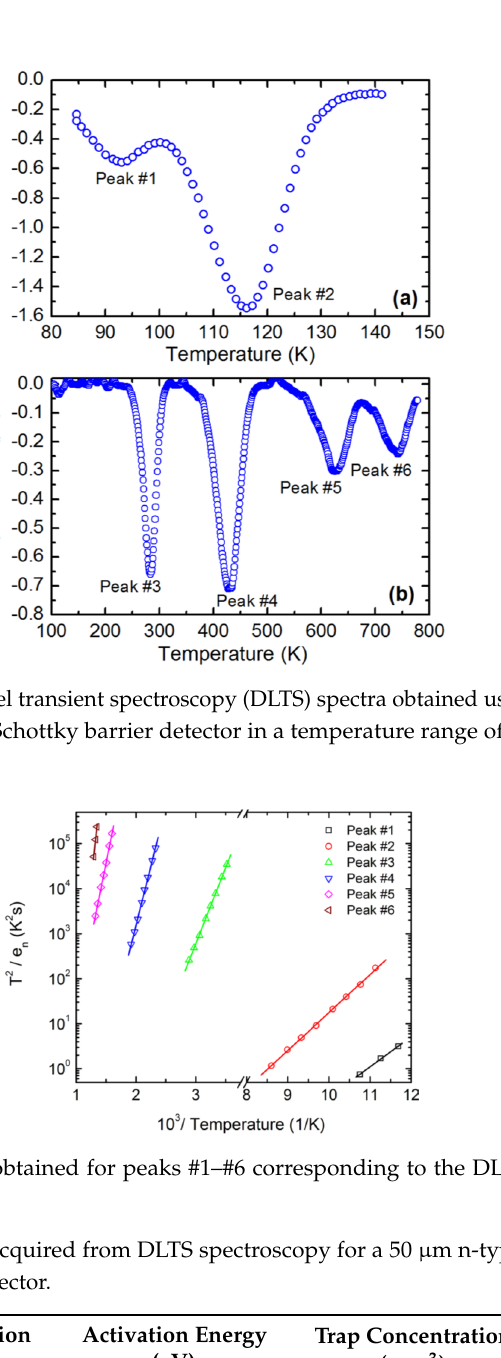
epitaxial Schottky barrier